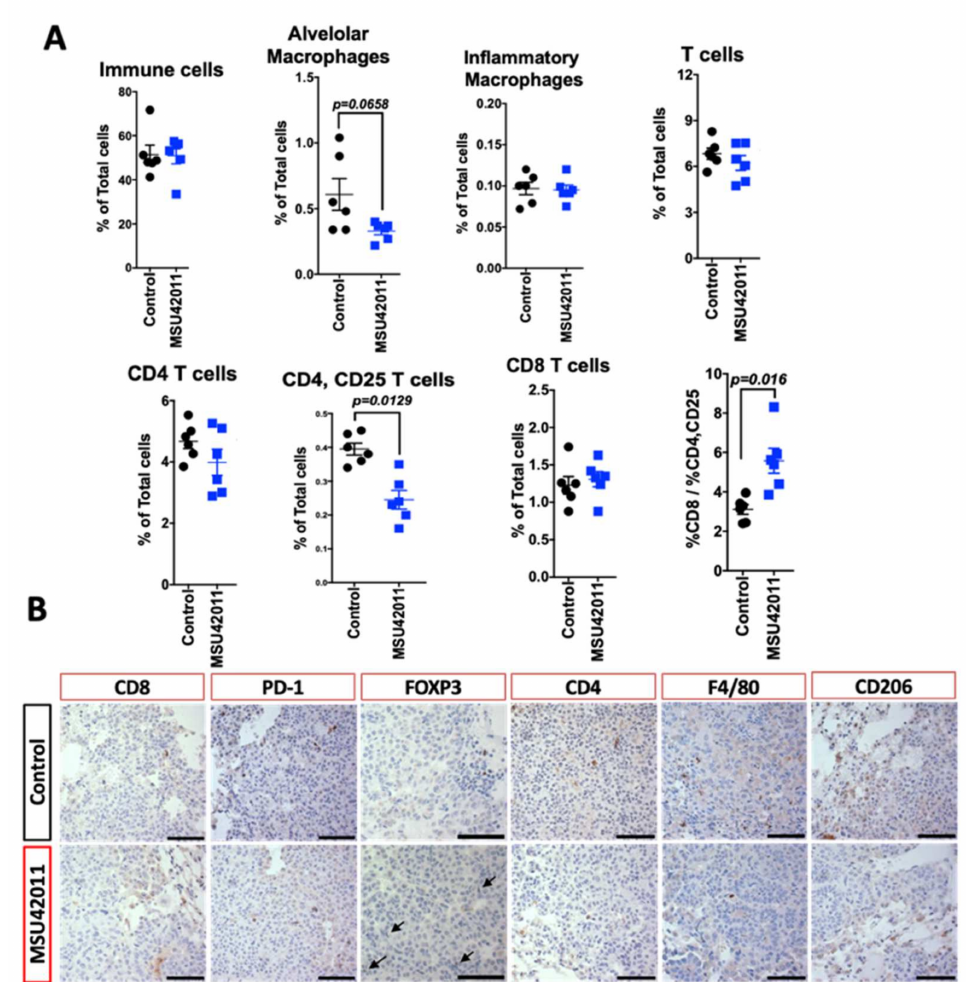
Figure 5. MSU42011 increases the percentage of activated CD8 cytotoxic T cells and decreases macrophages in the AJ model of lung carcinogenesis. ( A ) Flow cytometry analysis of whole lung lysates from A/J mice injected with vinyl carbamate to induced lung cancer ( n = 6/group). ( B ) Im- munohistochemistry of tumor sections to confirm the flow cytometry data. (scale bar 30 µ